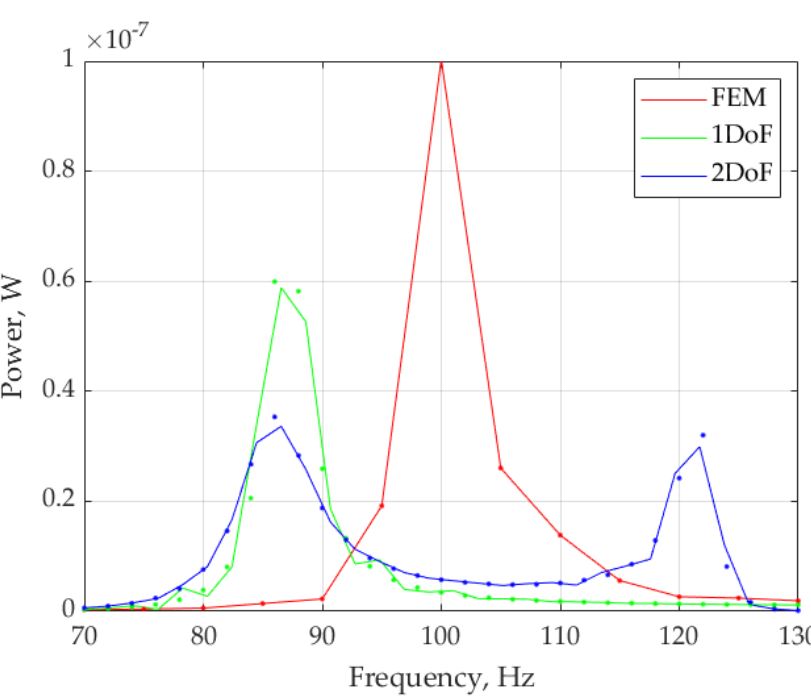
Figure 19. The amplitude as a function of the frequency of generated power was calculated for the 1-DoF and 2-DoF kinematic chain models and the FEM model.